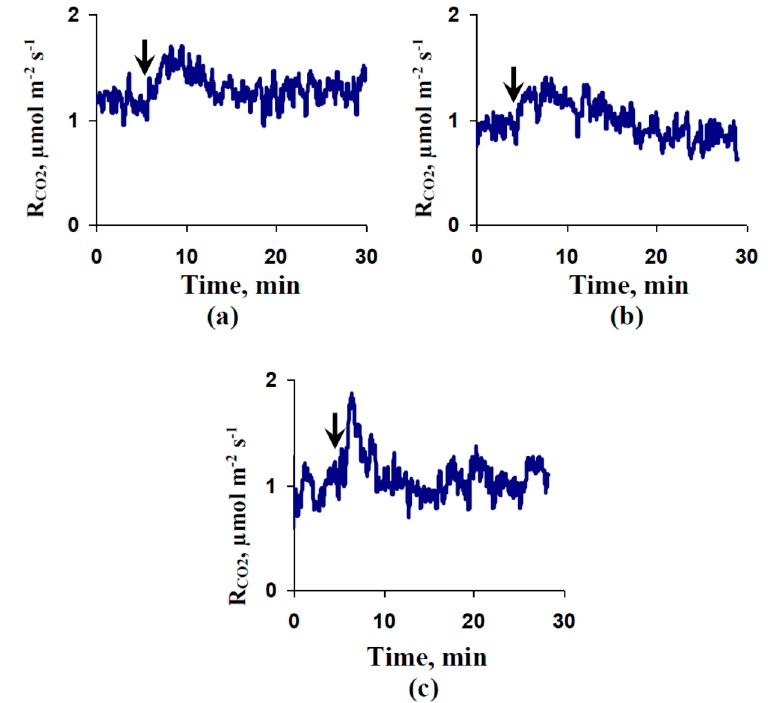
Figure 6. Examples of local burning-induced changes in respiration (R CO2 ) in the second leaf of pea seedlings under control conditions ( a ) and after preliminary treatment by sodium orthovanadate (OV) ( b ) and fusicoccin (FC) ( c ). Respiration was measured under dark conditions. The preliminary OV (0.5 mM) and FC (1 µM) treatments of the second mature leaves in seedlings were performed by incubation of the leaf (2 h) in solutions of these chemical agents. After that, these leaves were dried by filter paper and used for respiratory measurements. OV and FC were dissolved in standard solution (1 mM KCl, 0.5 mM CaCl 2 , and 0.1 mM NaCl). Similar incubation in the standard solution was used